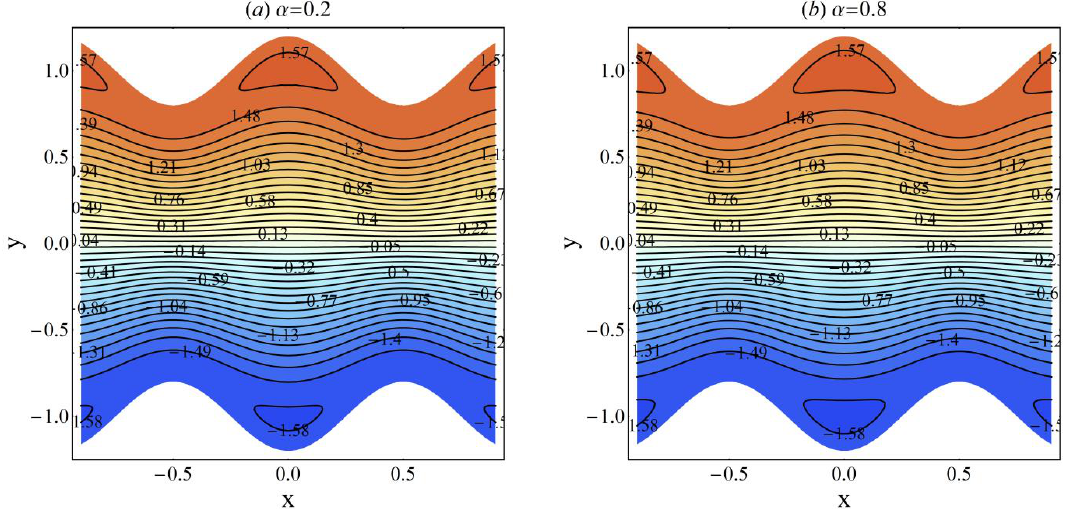
Figure 21. Streamlines at different α when Fr = 1, n = 0.2, ε = 0.2, We2 = 0.01, β = 0.5, ξ = π/3, Fr = M = 0.5 : (a) α = 0.2 and (b) α = 0.8.